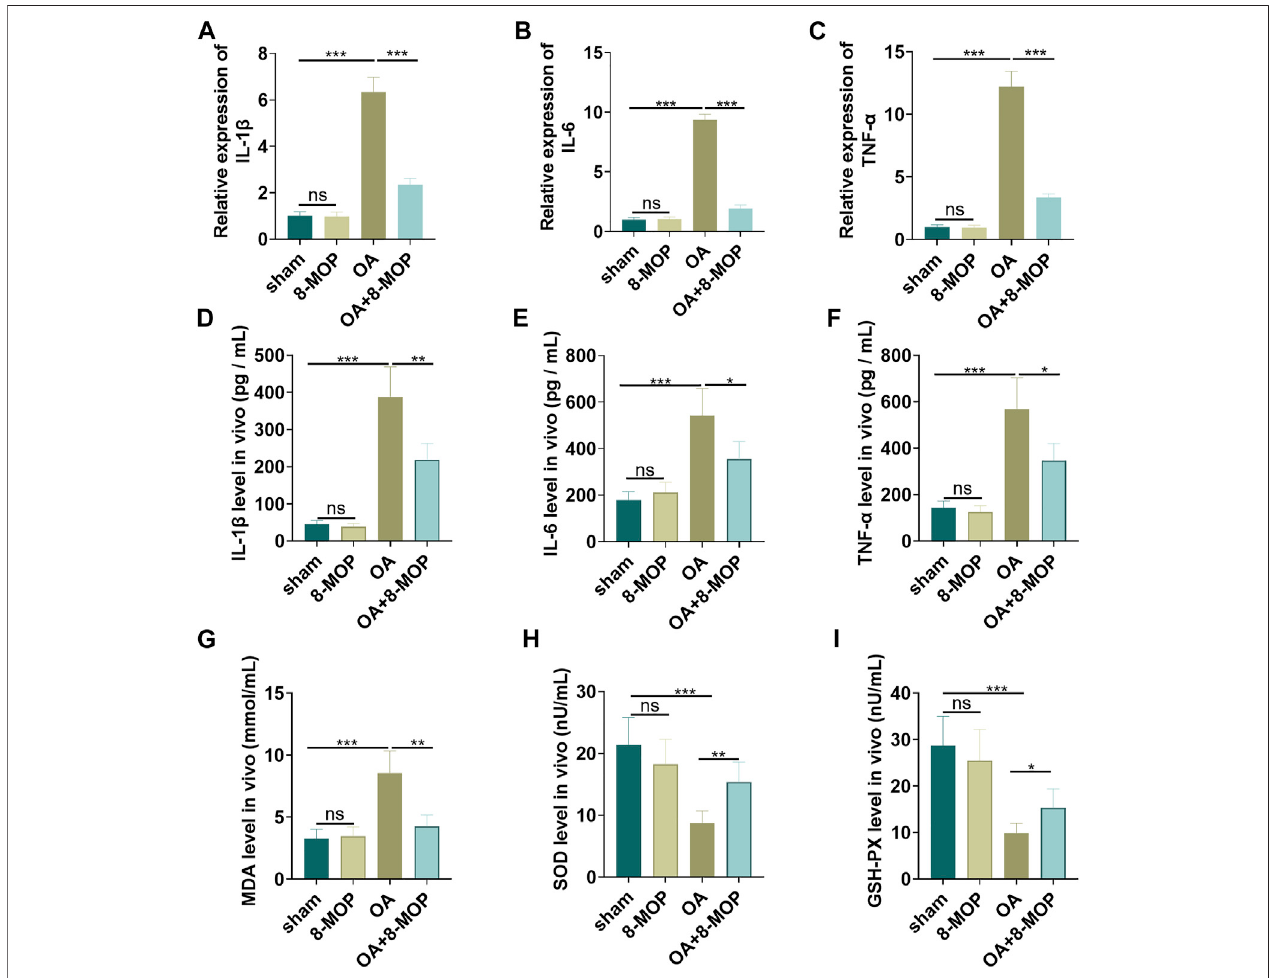
FIGURE 6 | 8-MOP relieved the in fl ammatory and oxidative stress responses in articular cartilage. The Wistar rat OA model was established by intraarticular injection of 4% papain. Rats were divided into four groups: The sham group, the 8-MOP (30 μ mol/kg, i.p.) group, the OA group, and the OA + 8-MOP (30 μ mol/kg, i.p.) group. (A – F) . The levels of in fl ammatory cytokines (IL-6, TNF- α , and IL-18) were detected by qRT-PCR and ELISA. (G – I) : The oxidative stress factors (MDA, SOD, and GSH-PX) in the OA site were measured by the MDA, SOD, and GSH-PX detection kits. ns p > 0.05, * p < 0.05, ** p < 0.01, *** p < 0.001. ( n (cid:1)